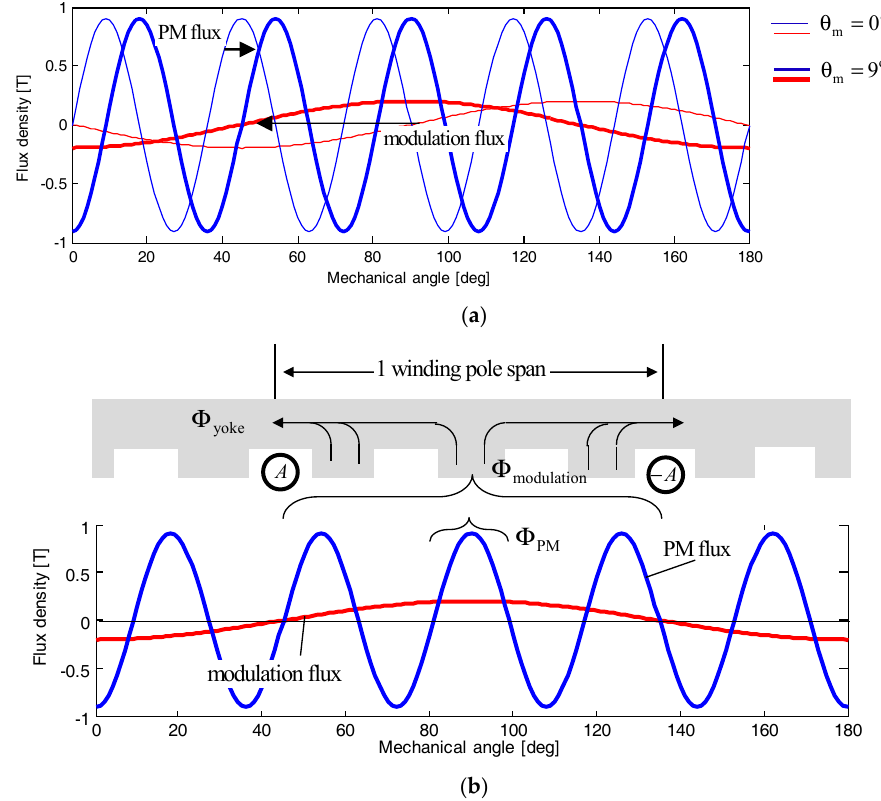
Figure 7. The first and fifth harmonic flux waveforms of the air gap of a vernier motor. ( a ) The waveforms when θ m = 0° and 9° showing the movements; ( b ) Diagram of the flux per winding pole when θ m = 9°.